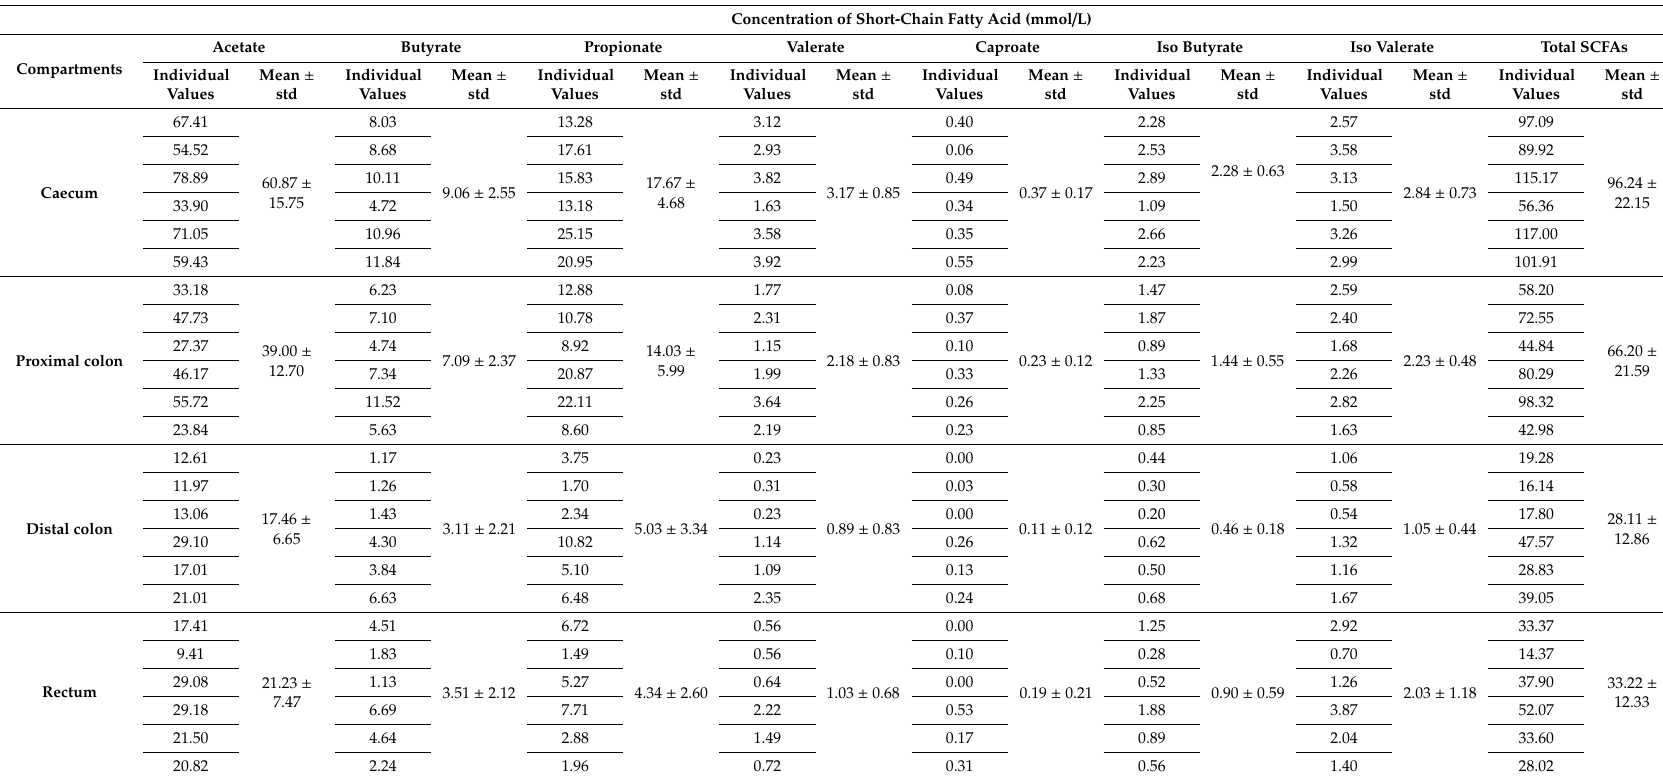
Table 1. Concentrations in mmol / L of SCFA measured in hindgut compartments of 28-day-old piglets by gas chromatography. (std = standard deviation). Concentration of Short-Chain Fatty Acid (mmol / L) Acetate Butyrate Propionate Valerate Caproate Iso Butyrate Iso Valerate Compartments